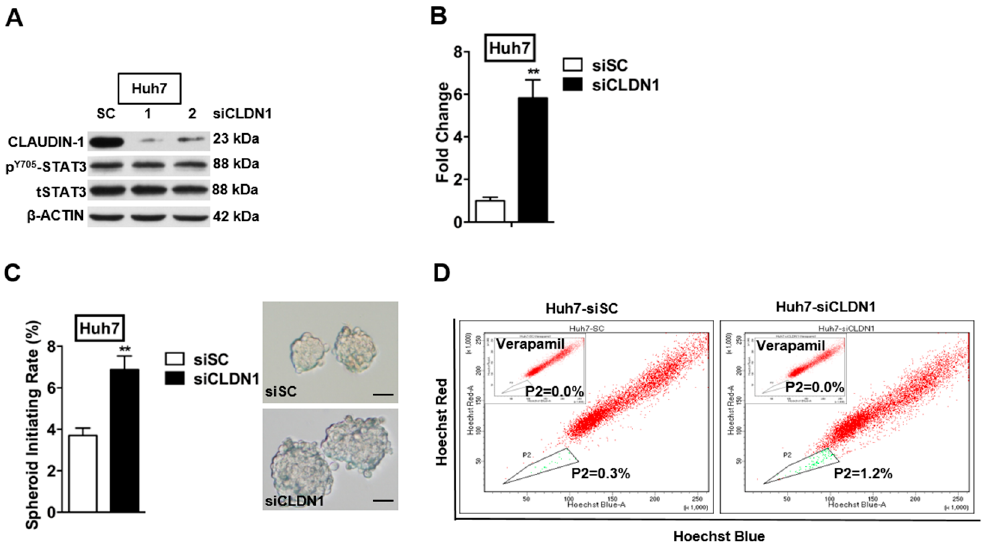
Figure 7. Depletion of CLAUDIN-1 enhances invasive and CSC-like properties of HCC cells. ( A ) Western blot analysis for CLAUDIN-1 expression and STAT3 activity in Huh7 cells transfected with CLAUDIN-1 specific siRNAs or scrambled siRNA; ( B ) Standard Transwell assay to assess the invasive potential of Huh7 cells transfected with CLAUDIN-1 specific siRNA, or scrambled siRNA as control. ** p < 0.01; ( C ) Suspension culture to determine the effect of CLAUDIN-1 depletion on self-renewal properties of CSC-like population in Huh7 cells. The Huh7 cells were transfected with CLAUDIN-1 specific siRNAs or scrambled siRNAs. The transfected cells were cultured with CSC medium in ultra-low attachment. ** p < 0.01; bar, 100 µm; ( D ) Hoechst 33,342 efflux assay to determine the effect of CLAUDIN-1 depletion on SP in Huh7 cells. The Huh7 cells were transfected with CLAUDIN-1 specific siRNAs or scrambled siRNA. The transfected cells were stained with Hoechst 33,342 in absence or presence of Verapamil, and then analyzed by flow cytometry. Verapamil was used to establish the baseline fluorescence of these cells. The side population within the triangle is represented by green dots, while the non-side population is represented by red dots.